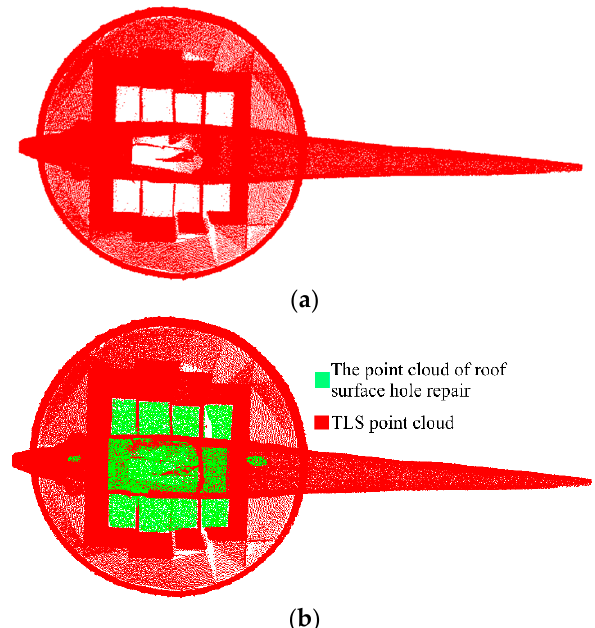
Figure 20. TLS point cloud roof surface hole repair. ( a ) TLS point cloud top view. ( b ) Top view of the TLS point cloud patched by the hole in the top surface.